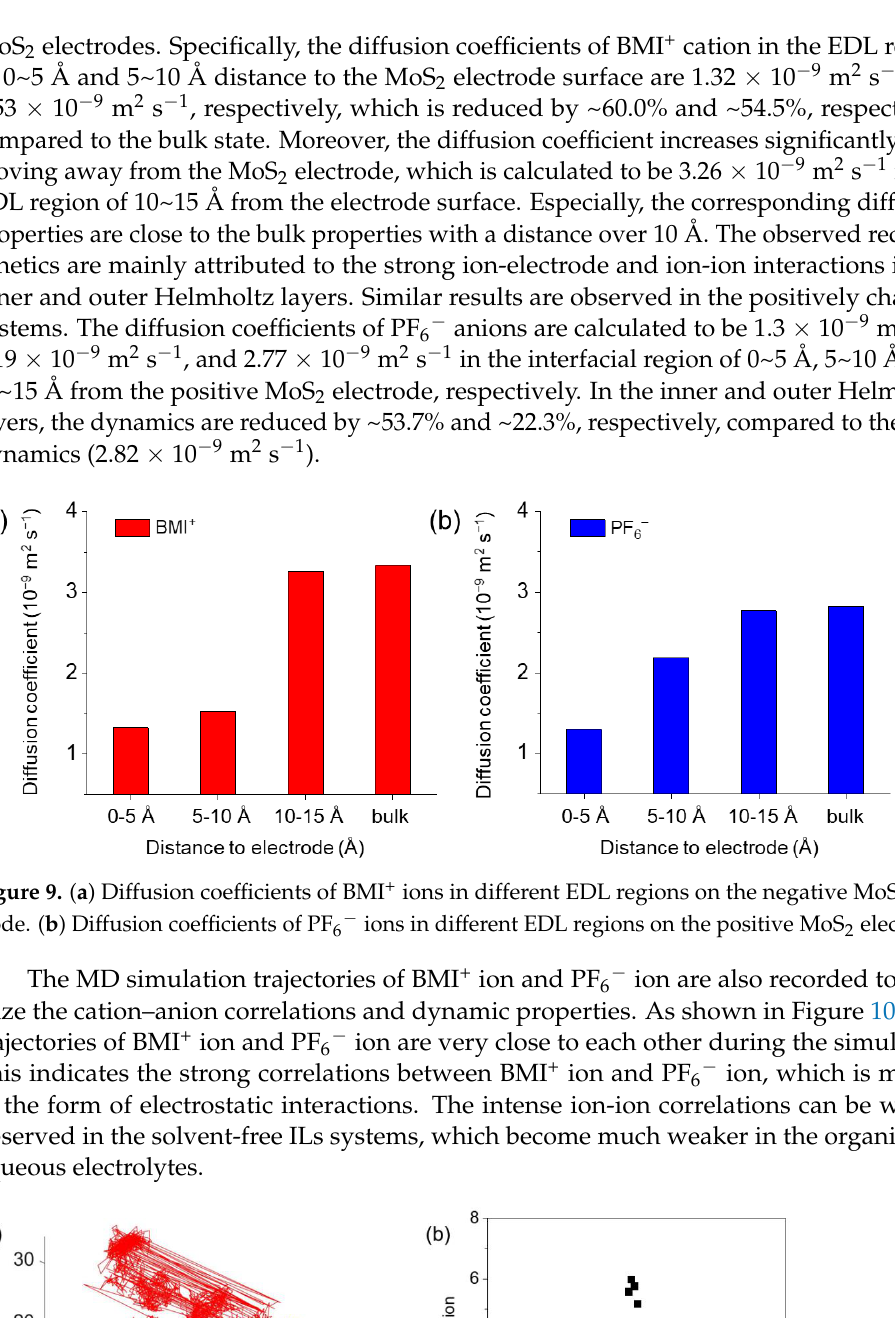
Figure 10. ( a ) MD simulation trajectory of BMI + ion (red color) and PF 6 − ion (blue color). ( b ) Radical distribution function between BMI + ion and PF 6 − ion.